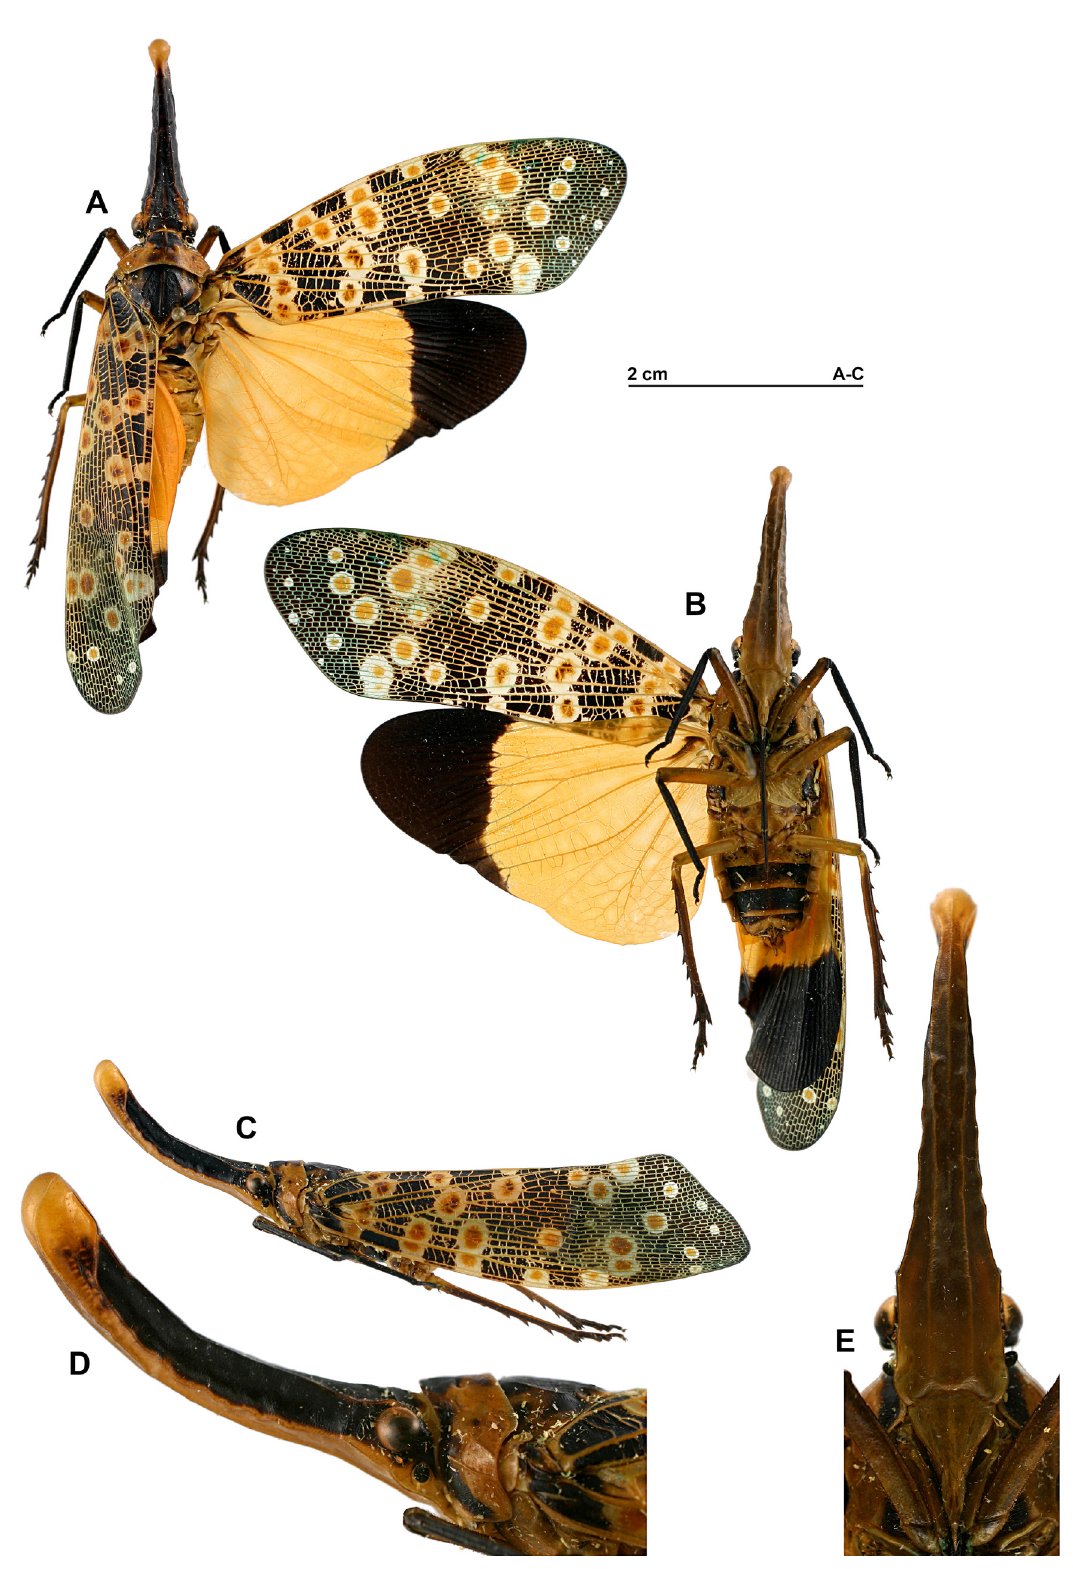
Fig. 14. Pyrops lathburii (Kirby, 1818), ♀, Vietnam, Cao Bang Prov., Phia Den, 8 Aug. 2010 (RBINS). A . Habitus, dorsal view. B . Habitus, ventral view. C . Habitus, lateral view. D . Head and thorax, lateral view. E . Head, perpendicular view of frons. D–E = not to